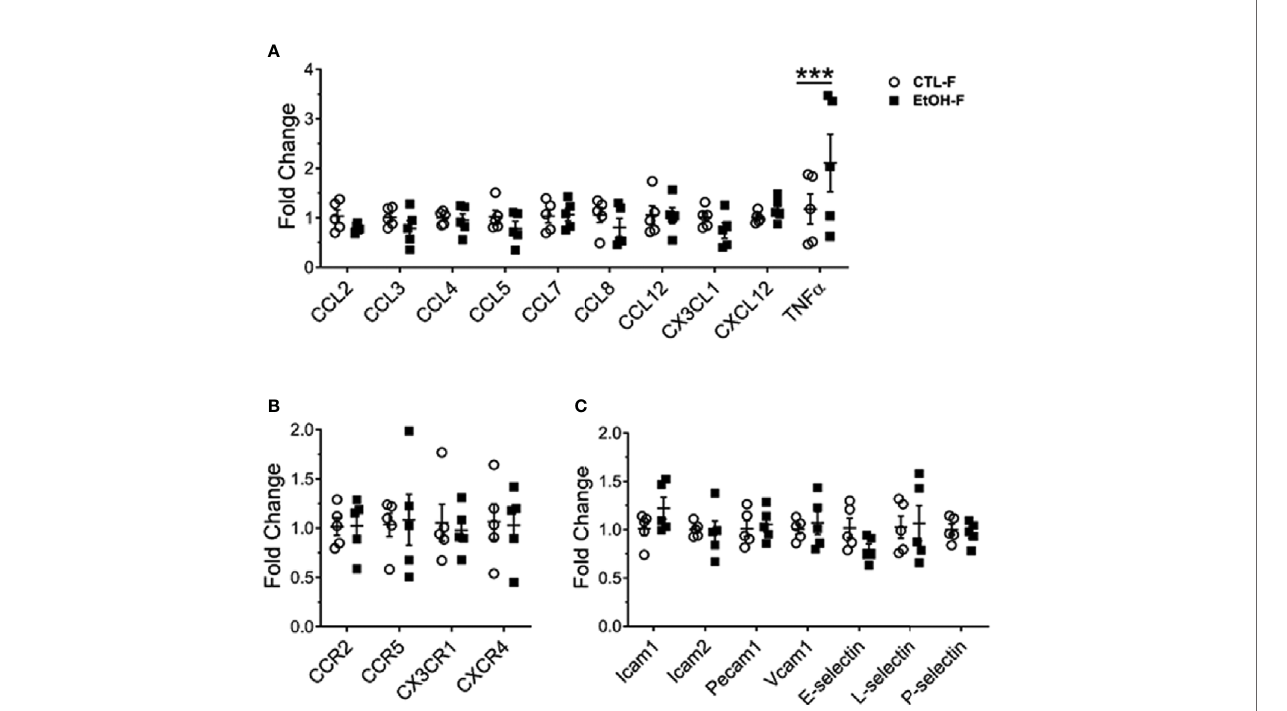
FIGURE 3 | Increase in hepatic TNF a in alcohol-fed female mice. Female wild type mice were provided a regular chow diet and ethanol in drinking water (EtOH) or ethanol-free water (CTL). After 4 weeks, mice were euthanized, and liver harvested. Hepatic total mRNA extracted followed by qRT-PCR analysis of chemokines (A) , chemokine receptor (B) , and adhesion molecules (C) involved in monocyte recruitment. Dot graphs showing fold change in gene expression in alcohol-fed versus control mice calculated by comparative Ct method. n = 5. Values are showing the mean ± SEM